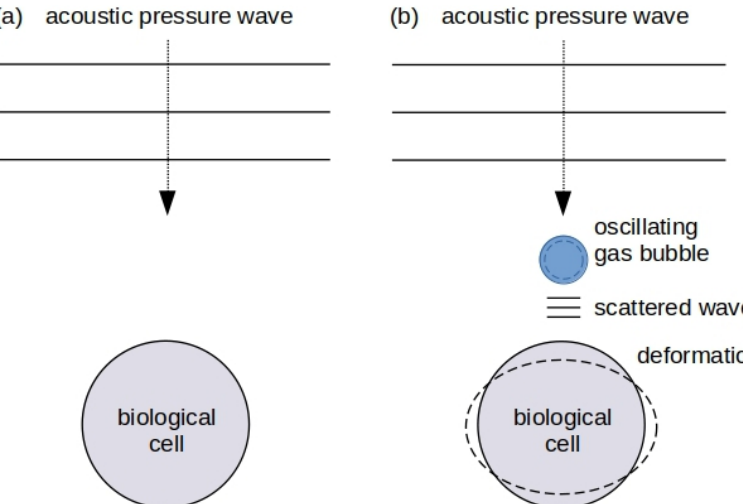
Figure 10. Illustration of the interaction of an oscillating bubble with a biological cell in the ultrasound acoustic pressure field. ( a ) Since a cell typically has a very small acoustic cross-section, the effect of a plain acoustic pressure wave on it at the frequency of its fundamental shape resonance is negligibly small. ( b ) Using a microbubble, one can efficiently excite the shape oscillations of the cell since the bubble acts as a point-like source of acoustic pressure waves. As a result, the cell can be deformed and its mechanical properties can be measured in a non-contact